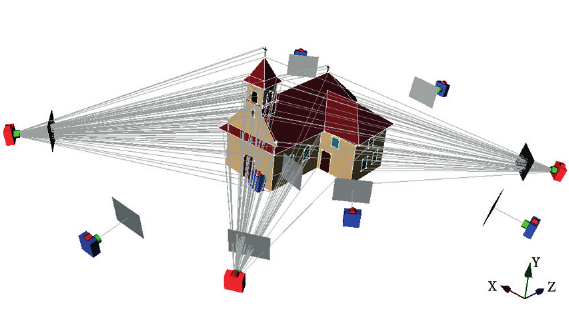
Fig. 6. 3D model with the position of photogrammetric stations (view